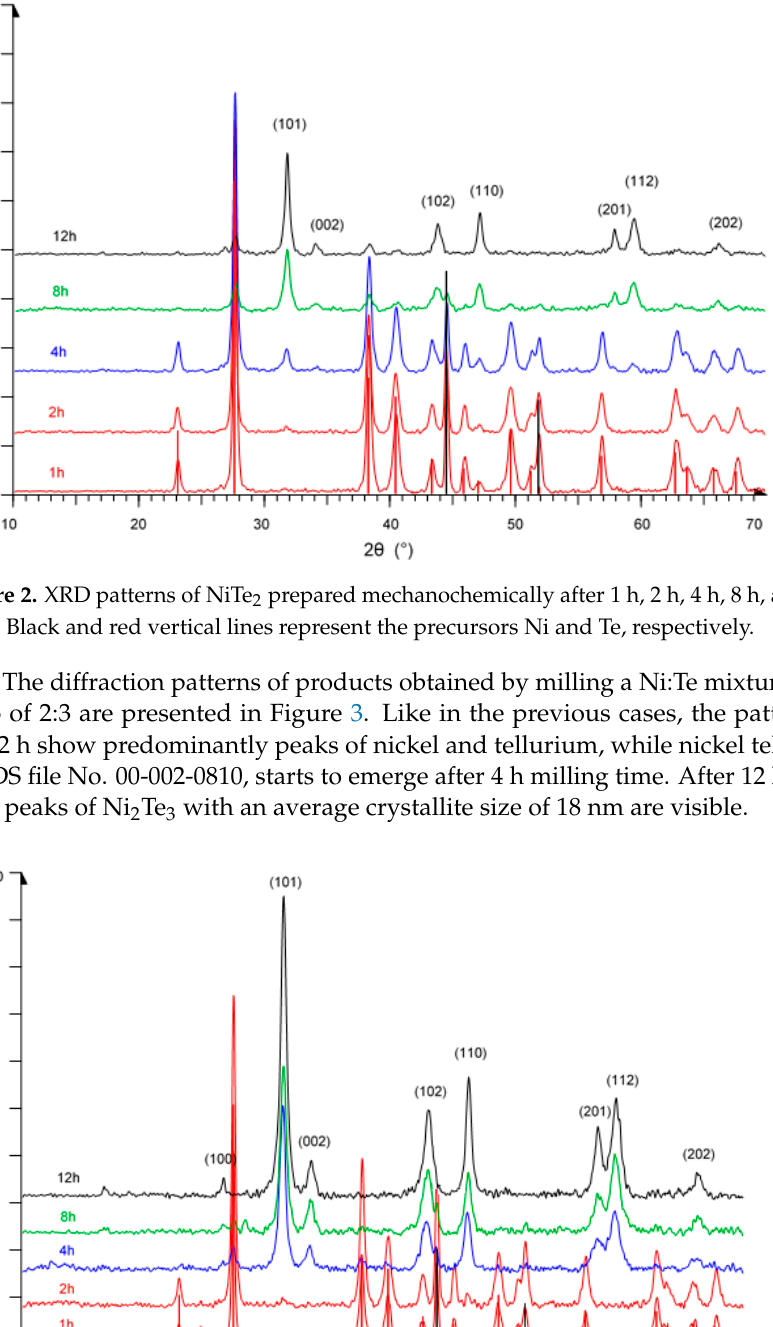
Figure 1. XRD patterns of NiTe prepared mechanochemically after 1 h, 2 h, 4 h, and 8 h milling time. Black and red vertical lines represent the precursors Ni and Te, respectively.